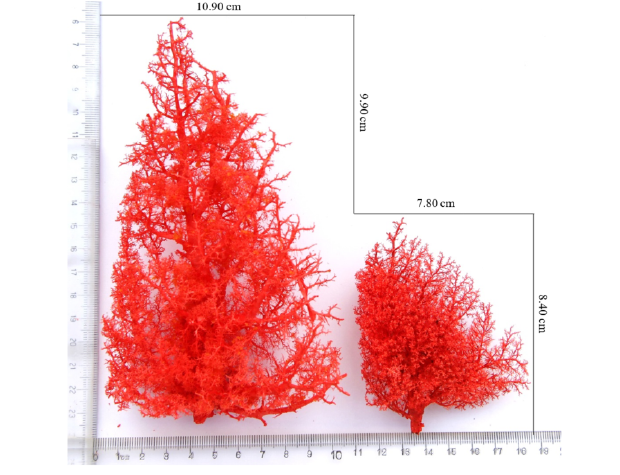
Figure 2. Morphological features of the pulmonary artery. Tibetan pig cast specimens of the pulmonary artery are on the left, and Lan- drace pig cast specimens of the pulmonary artery are on the